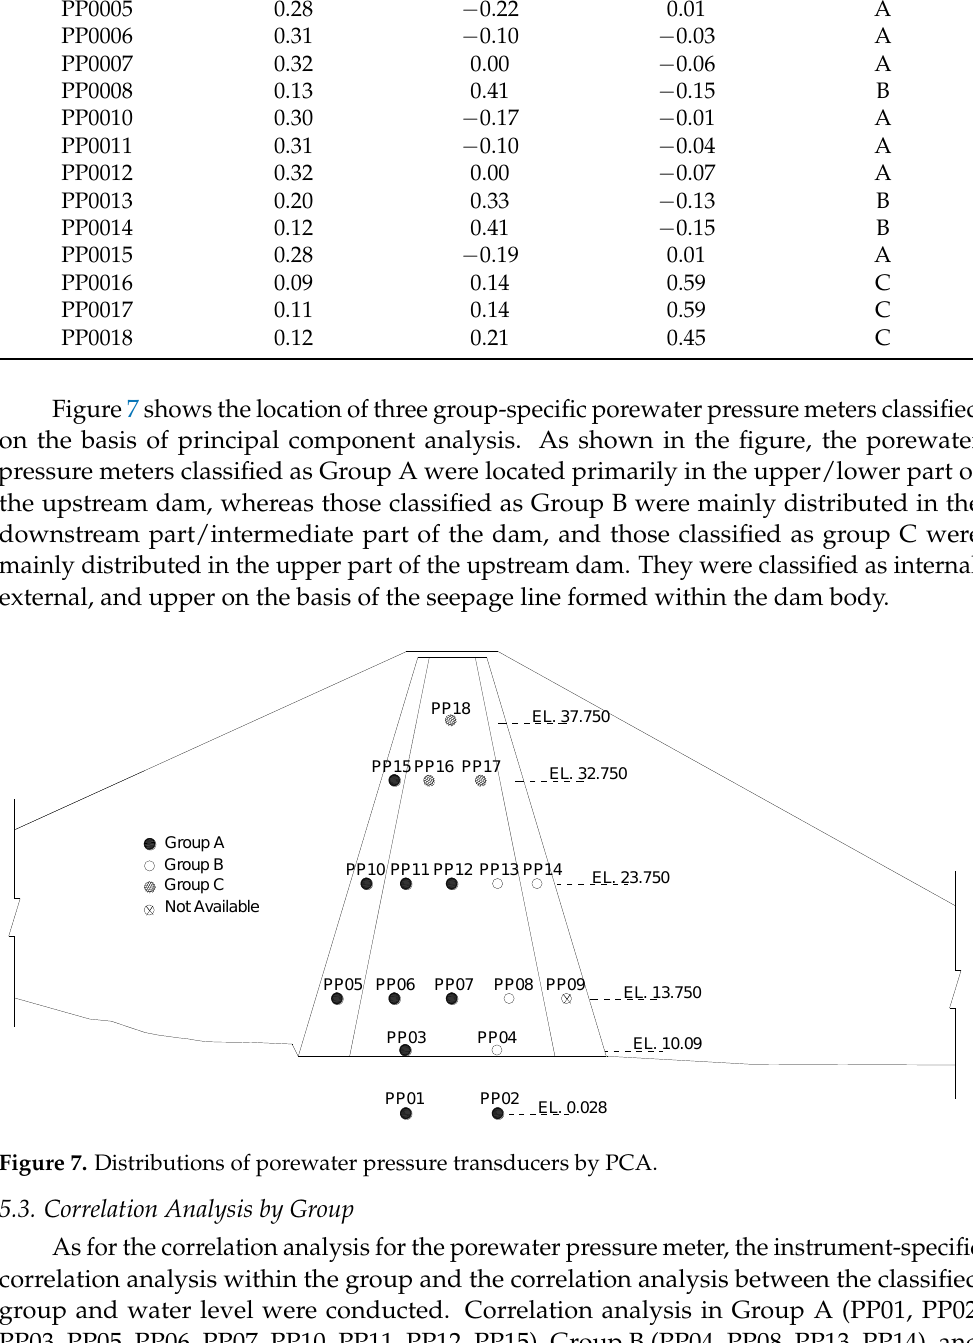
Figure 6. Results of the PCA. Table 3. Coefficient matrix for component scores and group distributions for porewater pressures.